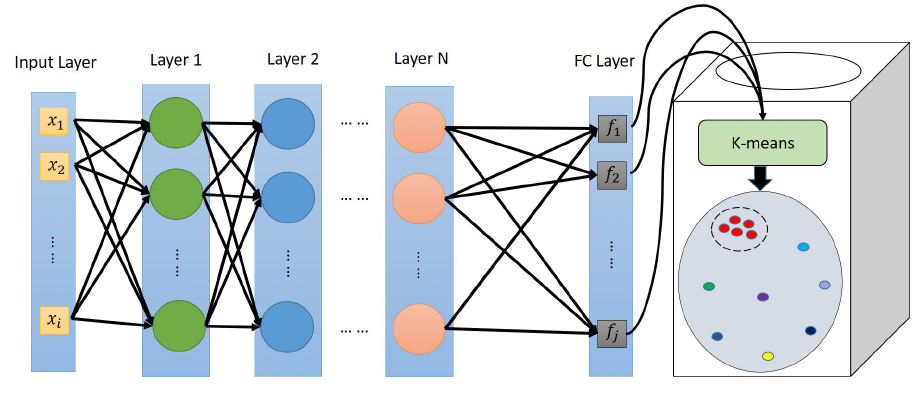
Figure 2. The architecture of K-means clustering.